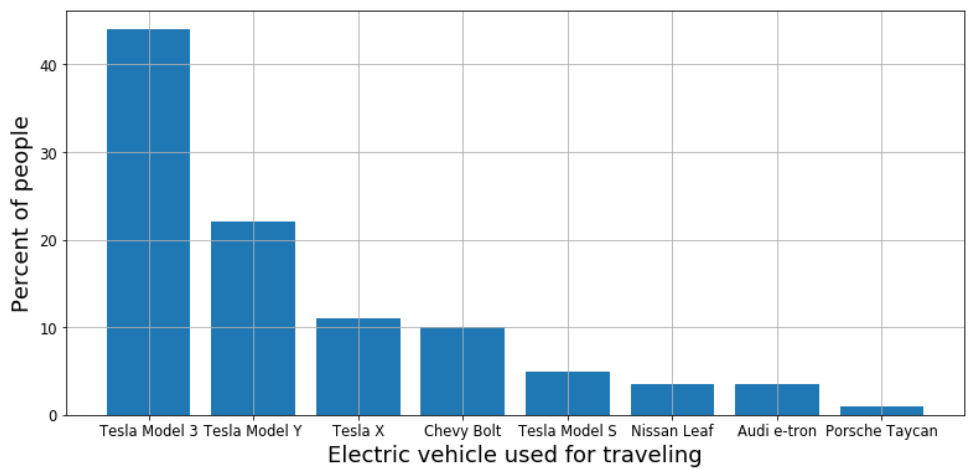
Figure 5. Distribution of the plug-in vehicle types.